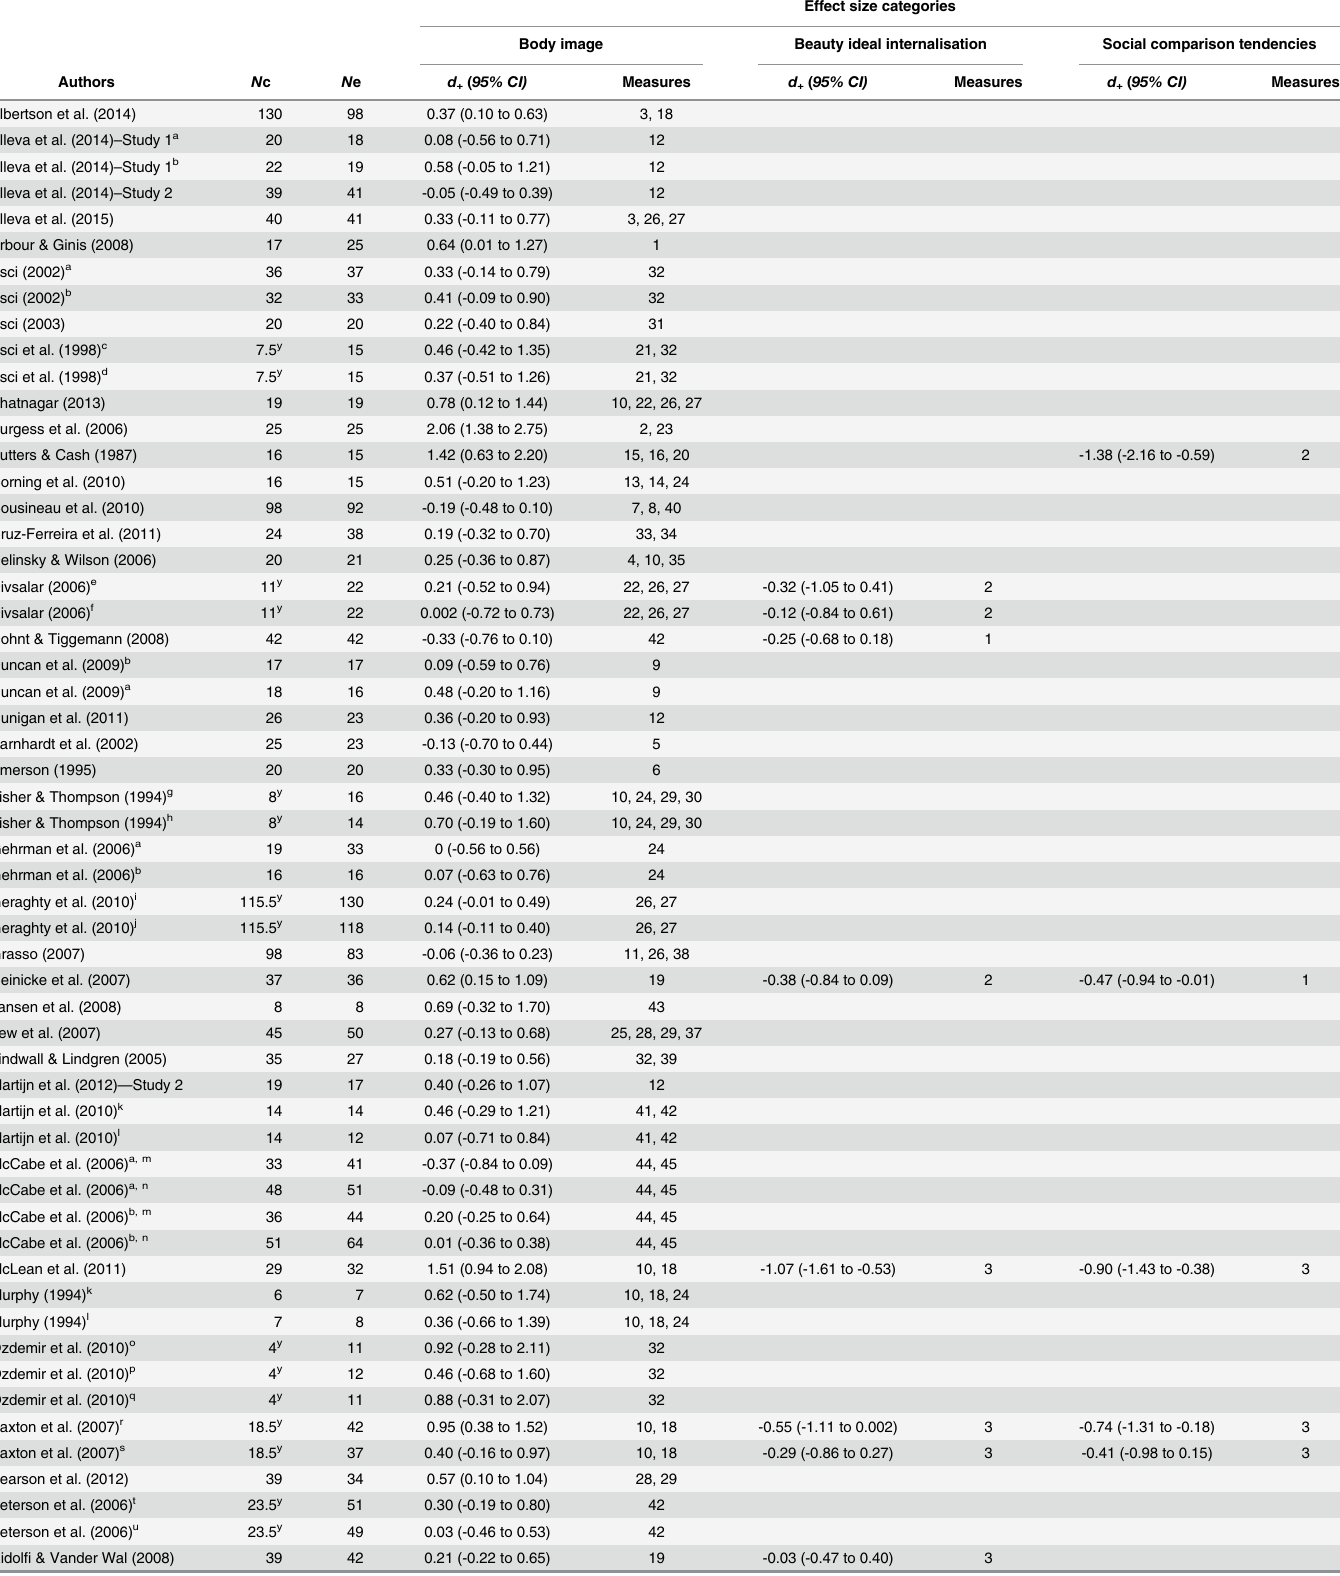
Table 2. Effect Sizes for Studies Included in the